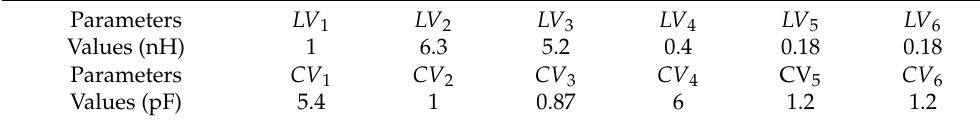
Table 2. Obtained values for the applied lumped elements of the LC model of the coupler.